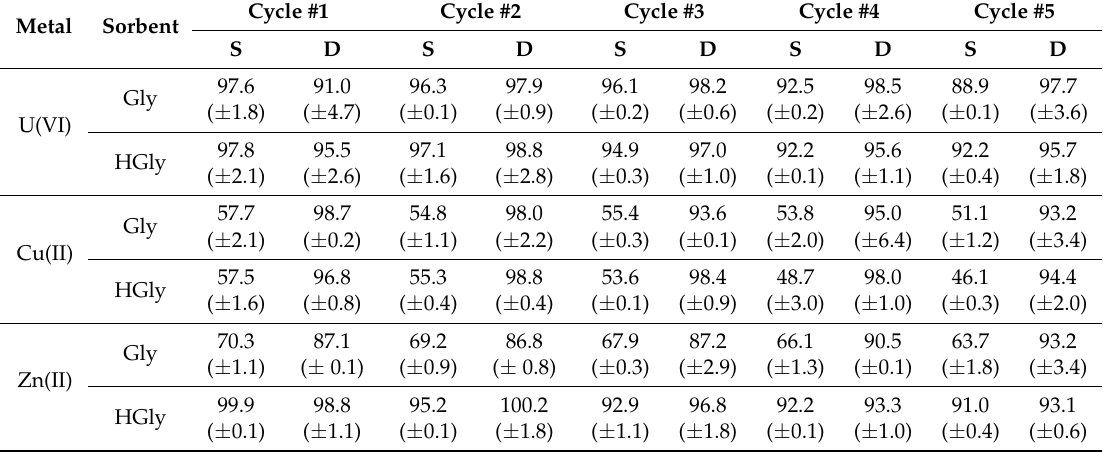
Table 5. Sorbent recycling–Sorption (S) and desorption (D) efficiencies (%) over five cycles (conditions for sorption/desorption with concentrating effect: volume of desorption corresponds to 1/10 volume of